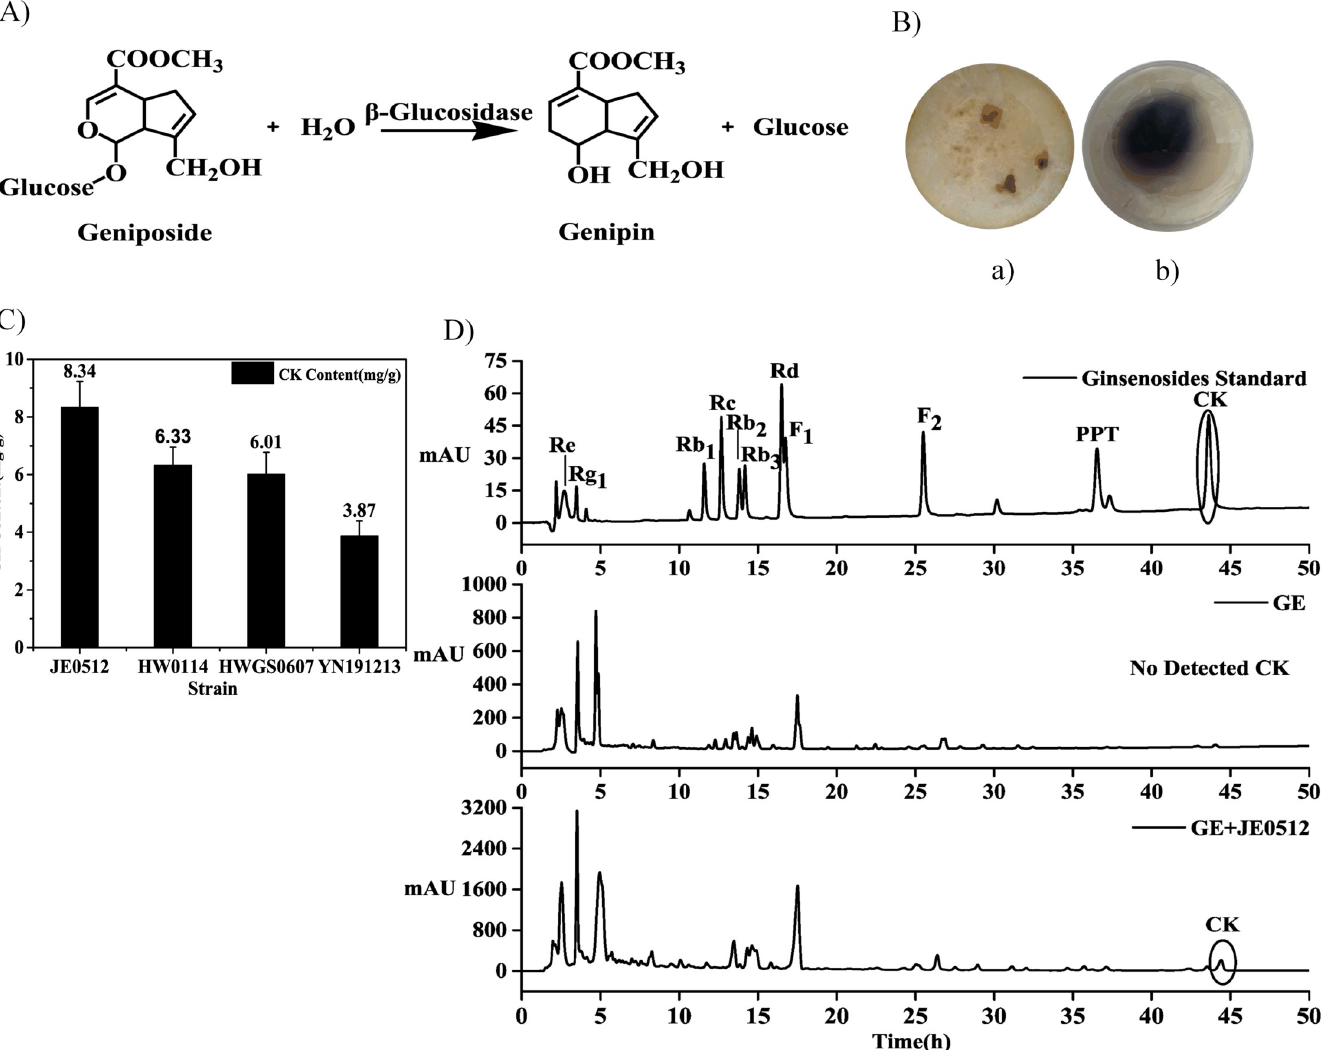
Fig 2. Screening of strains biotransformed GE into CK. A: Geniposide was hydrolyzed to genipin by β -glucosidase; B: Colonies on the plate without glucosidase activity (a), colonies with a blue circle had a higher β -glucosidase activity (b); C: Comparison the ability of strains to biotransform GE into CK. Values are means ± SD of three replications; D: HPLC profiles of ginsenosides in ginsenosides standard, GE, and GE fermented with JE0512.